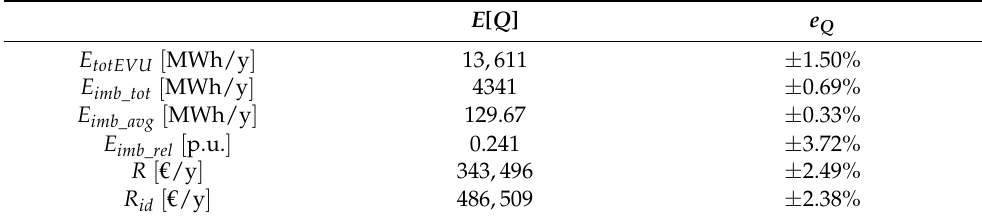
Table 3. Results relevant to the base case scenario.